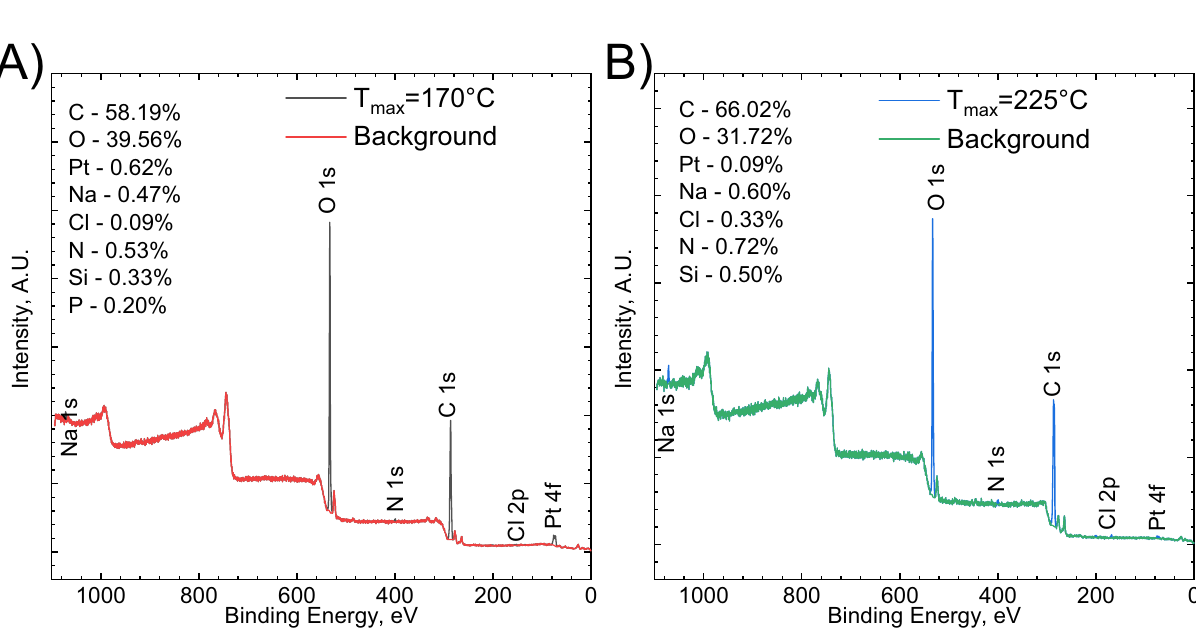
Figure 10. Photographical depiction of the colloids obtained after reduction in the microwave autoclave reactor, [Pt(IV)] = 1 × 10 −4 [TSC] = 2 × 10 −3 M.